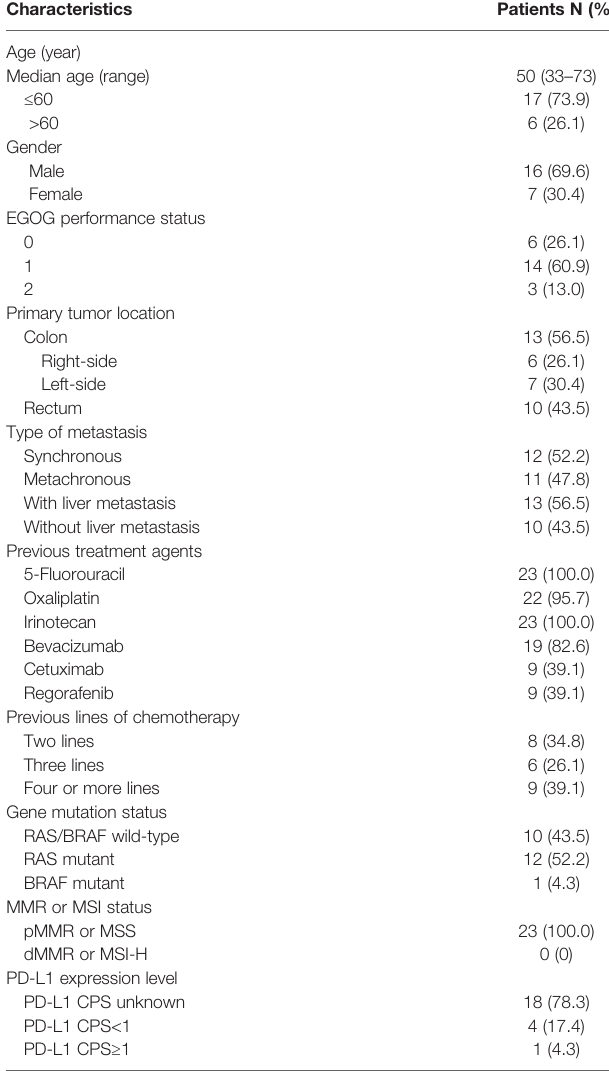
TABLE 1 | Baseline demographic and clinical characteristics of 23 mCRC